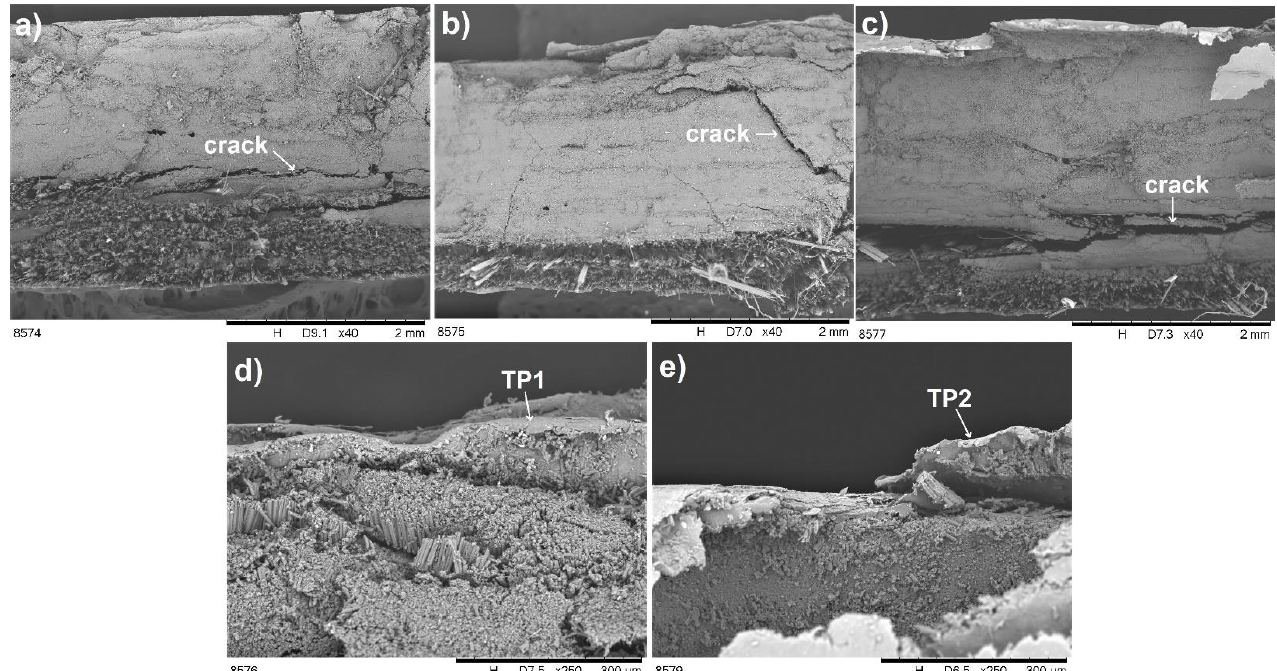
Figure 10. Microstructure of laminates after impact tests: ( a ) L1, ( b , d ) L2, ( c , e )